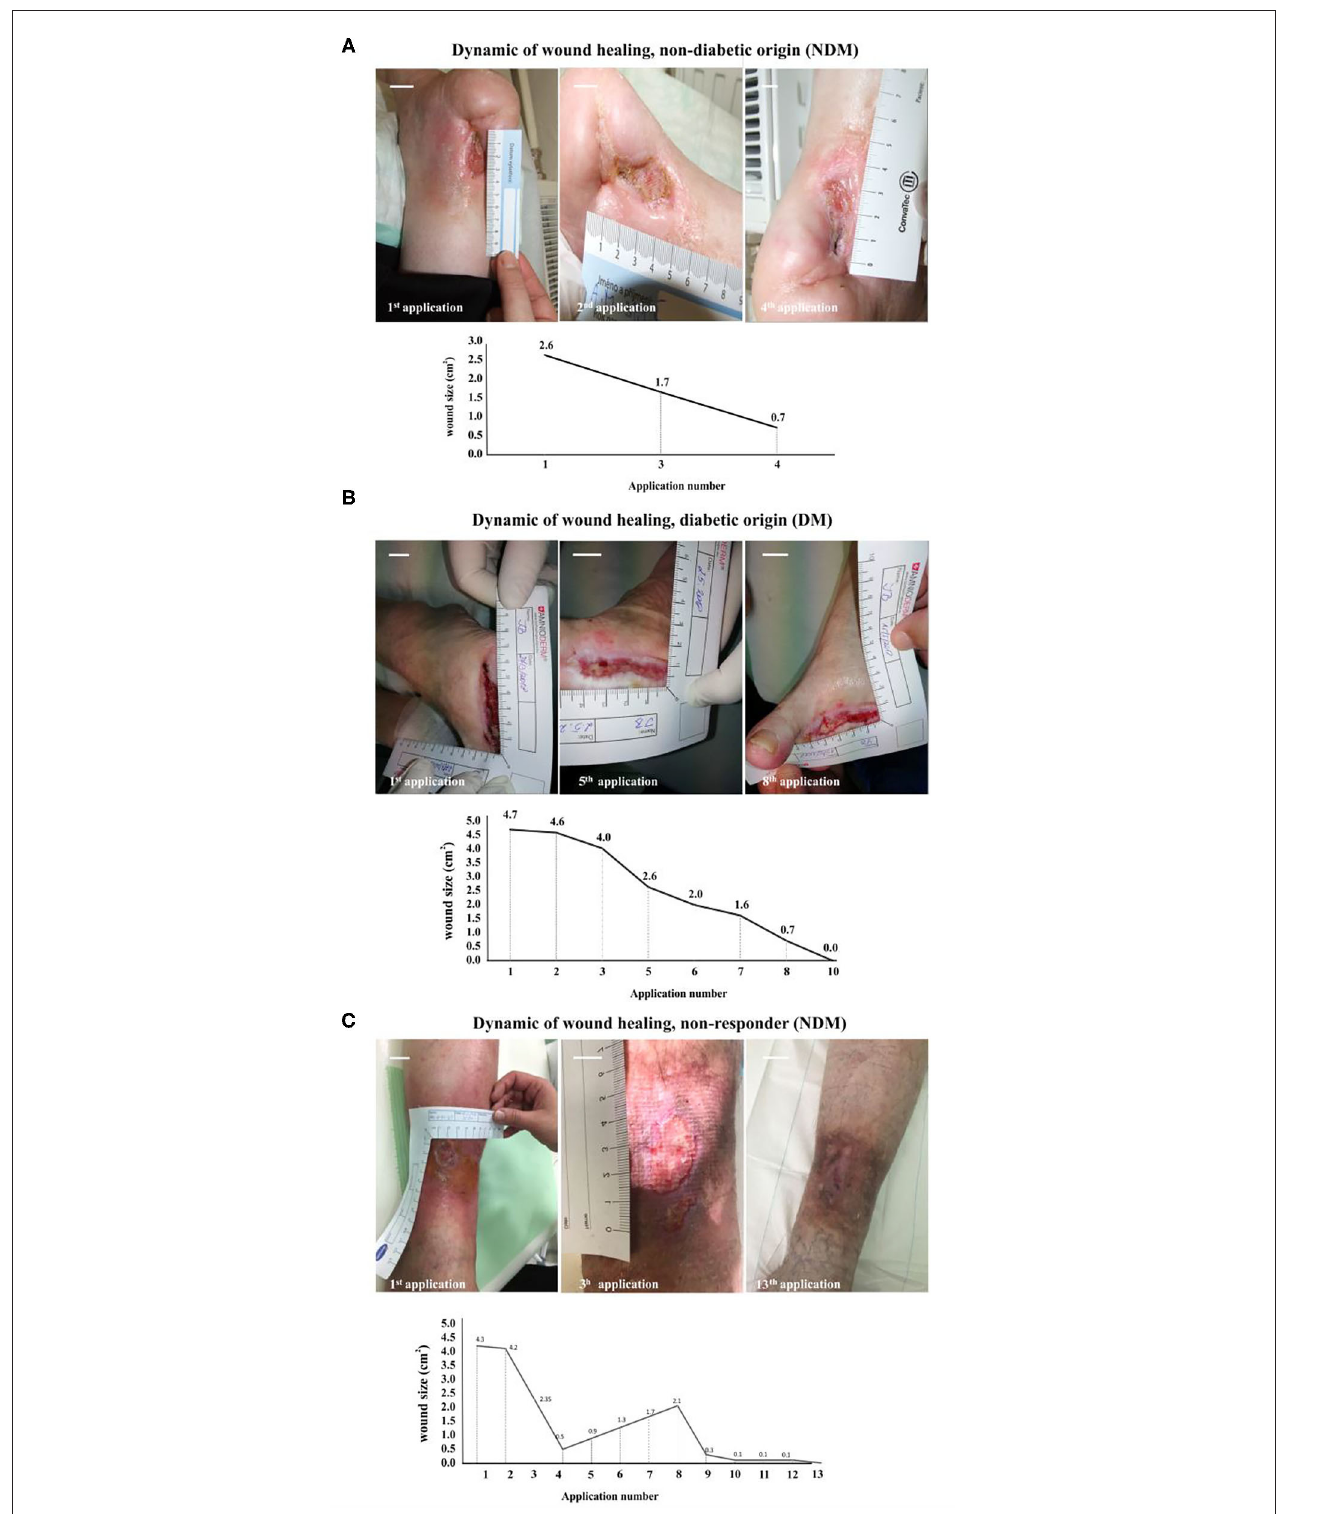
FIGURE 2 | Wound healing dynamics after Amnioderm ® application: NDM (A) , DM (B) , and non-responder NDM (C) groups. A female patient (69 years old) suffering from a non-diabetic chronic wound for 12 months (A) . After four Amnioderm ® applications, a significant reduction of ulcer size was observed, leading to complete